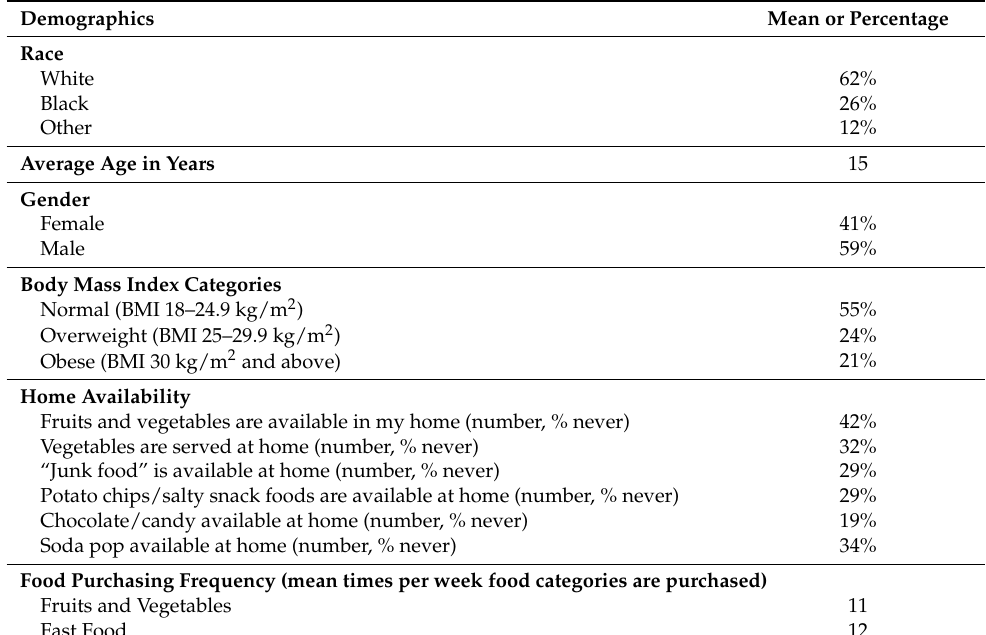
Table 2. Description of the study sample, adolescents ages 14–16 years in eight counties in Kentucky and North Carolina, 2017 ( n =